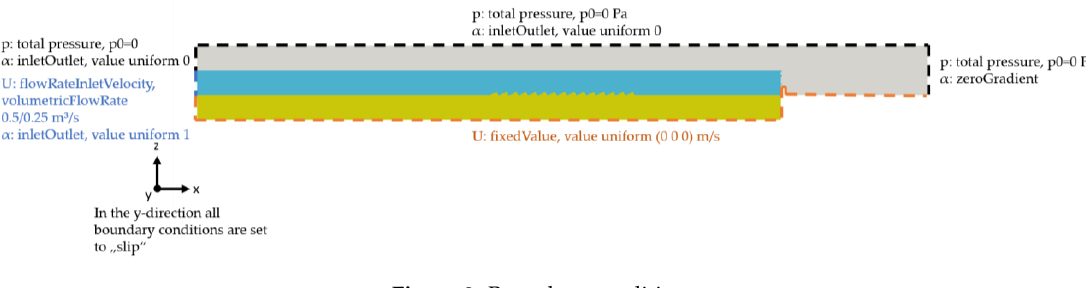
Figure 2. Boundary Figure 2. Boundary conditions .